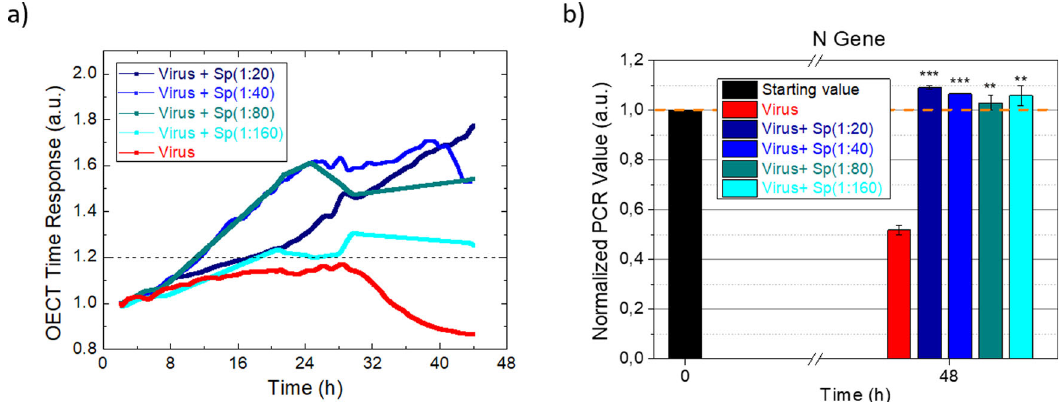
Fig. 4 Serumneutralization assay using TECH-OECT prototype. a Serum neutralization assay was performed using the TECH-OECT system. A neutralizing serum (Sp), with titer above 80, was progressively diluted in cultures infected by SARS-CoV-2, real-time monitoring the cell line using the automatized OECT technology for 44 h. b qRT-PCR Allplex Seegene data normalized to the starting value at the beginning of each experiment. The orange dashed line is inserted to stress the difference between viral proliferating cultures, having reduced or similar PCR value after 48 h, and viral-neutralized ones, with increasing PCR value. ** p < 0.01 and *** p < 0.001 denote signi fi cant differences with respect to the “ Virus ” data